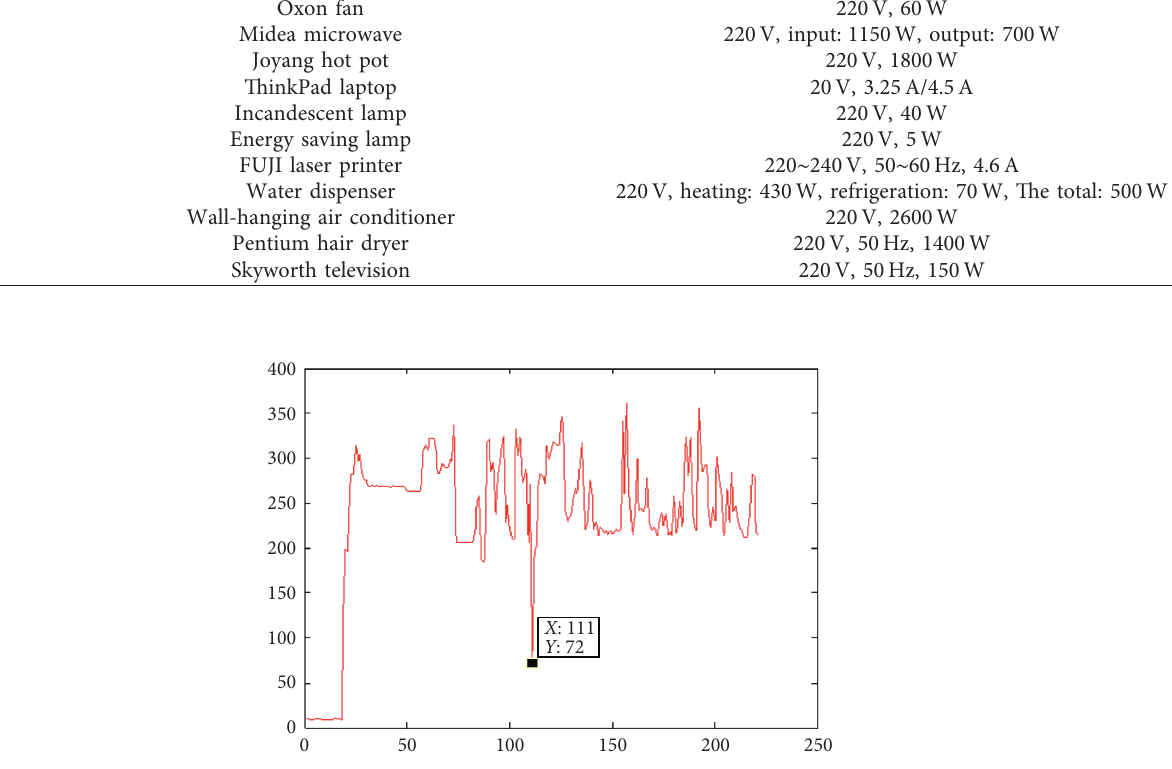
Figure 2: Abnormal points detection map.